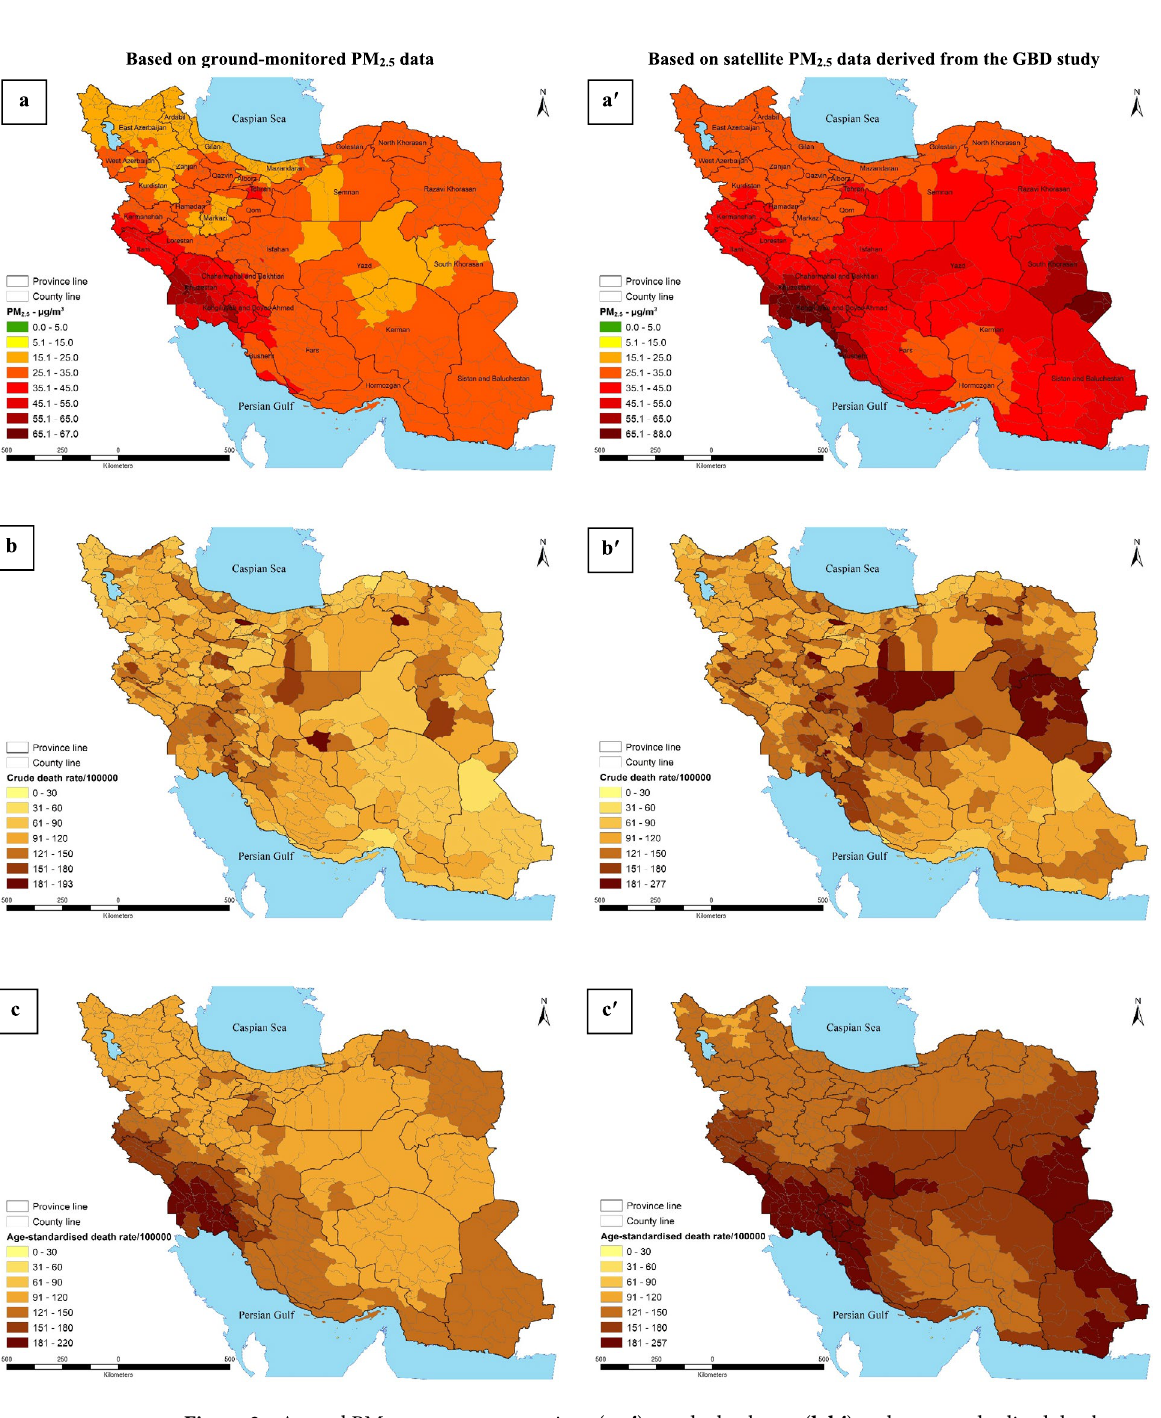
Figure 3. Annual PM 2.5 mean concentrations ( a , a ′ ), crude death rate ( b , b ′ ) and age-standardized death rate ( c , c ′ ) per 10 5 population aged ≥ 25 years old attributable to PM 2.5 in all Iranian counties, 2018 (these figures were generated by ArcGIS